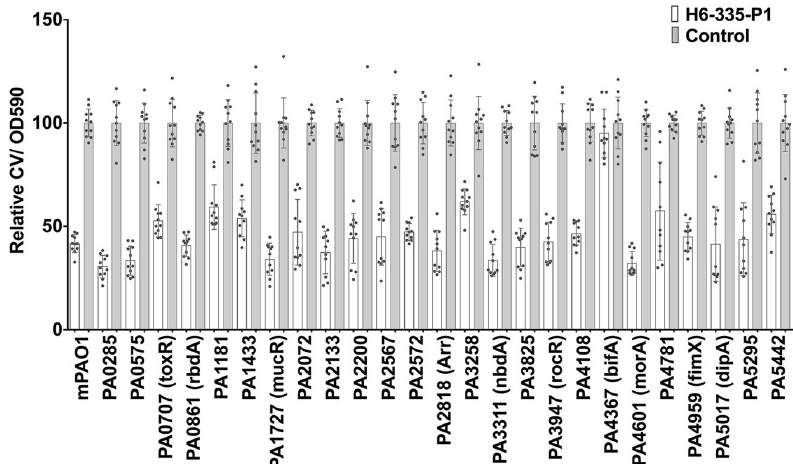
Fig. 9 A functional BifA is required for H6-335-P1-induced dispersal of P. aeruginosa bio fi lm. Bio fi lms of the P. aeruginosa wild-type and PDE mutants were grown in the wells of microtiter trays for 18 h, at which time point 100 μ M H6-335-P1 or DMSO-control was added to the wells. After 2 hours of further incubation, the culture supernatants were discarded and the amount of bio fi lm present in the wells was quanti fi ed by crystal violet staining. The graph shows relative values, where the average crystal violet value of each DMSO-control was set to 100. Mean value and standard deviation (bars) of 11 biological replicates ( n = 11) are shown. One-way ANOVA analysis with Sidak ’ s multiple comparisons test was used to calculate signi fi cance values between control and H6-335-P1-treated. P < 0.0001 was found for all comparisons, except PA4367 ( bifA ) for which H6-335-P1-treated was not signi fi cantly different from the control ( p > 0.05).